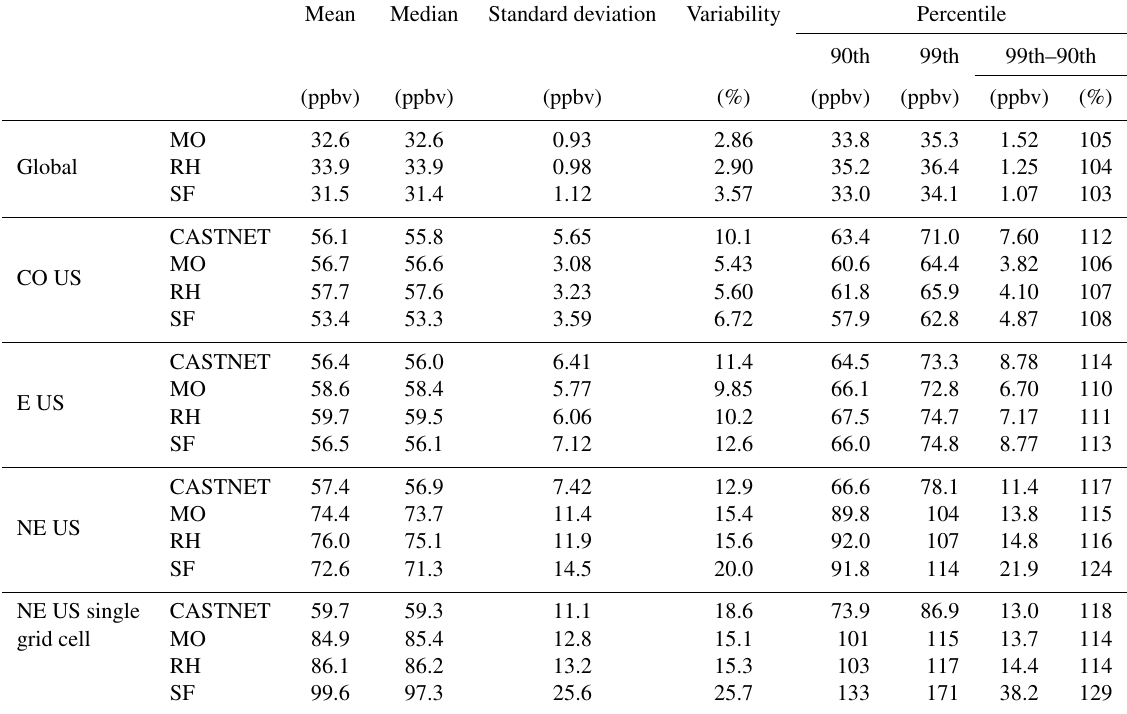
Table 2. Summary statistics for the daily maximum 8h (MDA8) O 3 over the globe and over the indicated regions in the US. Additional regions can be found in Table